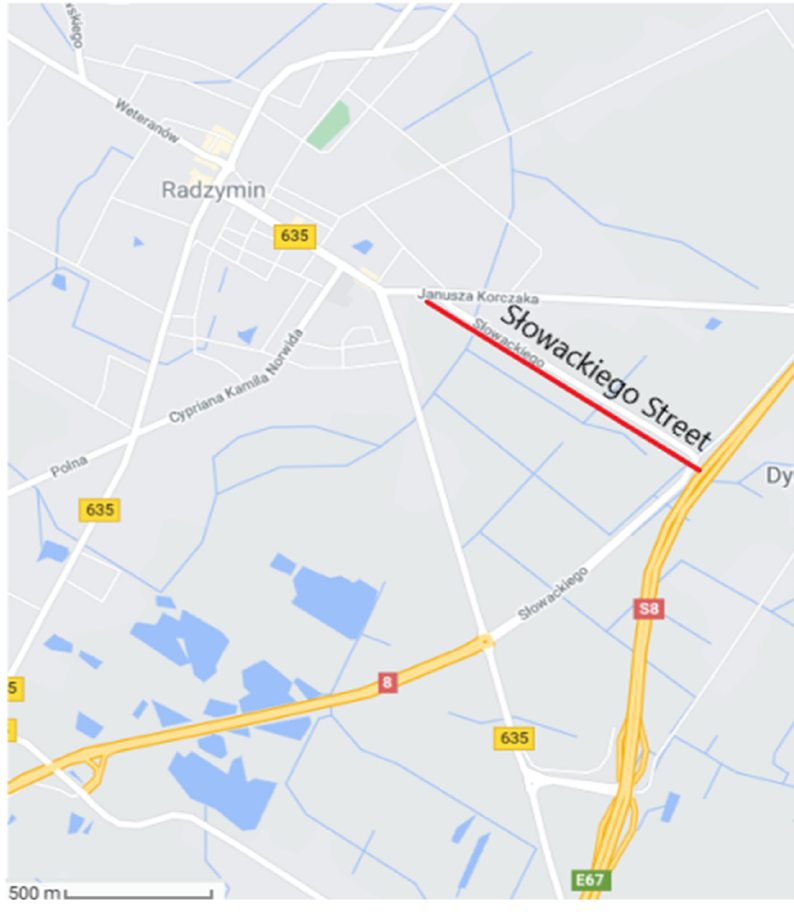
Figure 3. Slowackiego Street in Radzymin—view by Google Maps.